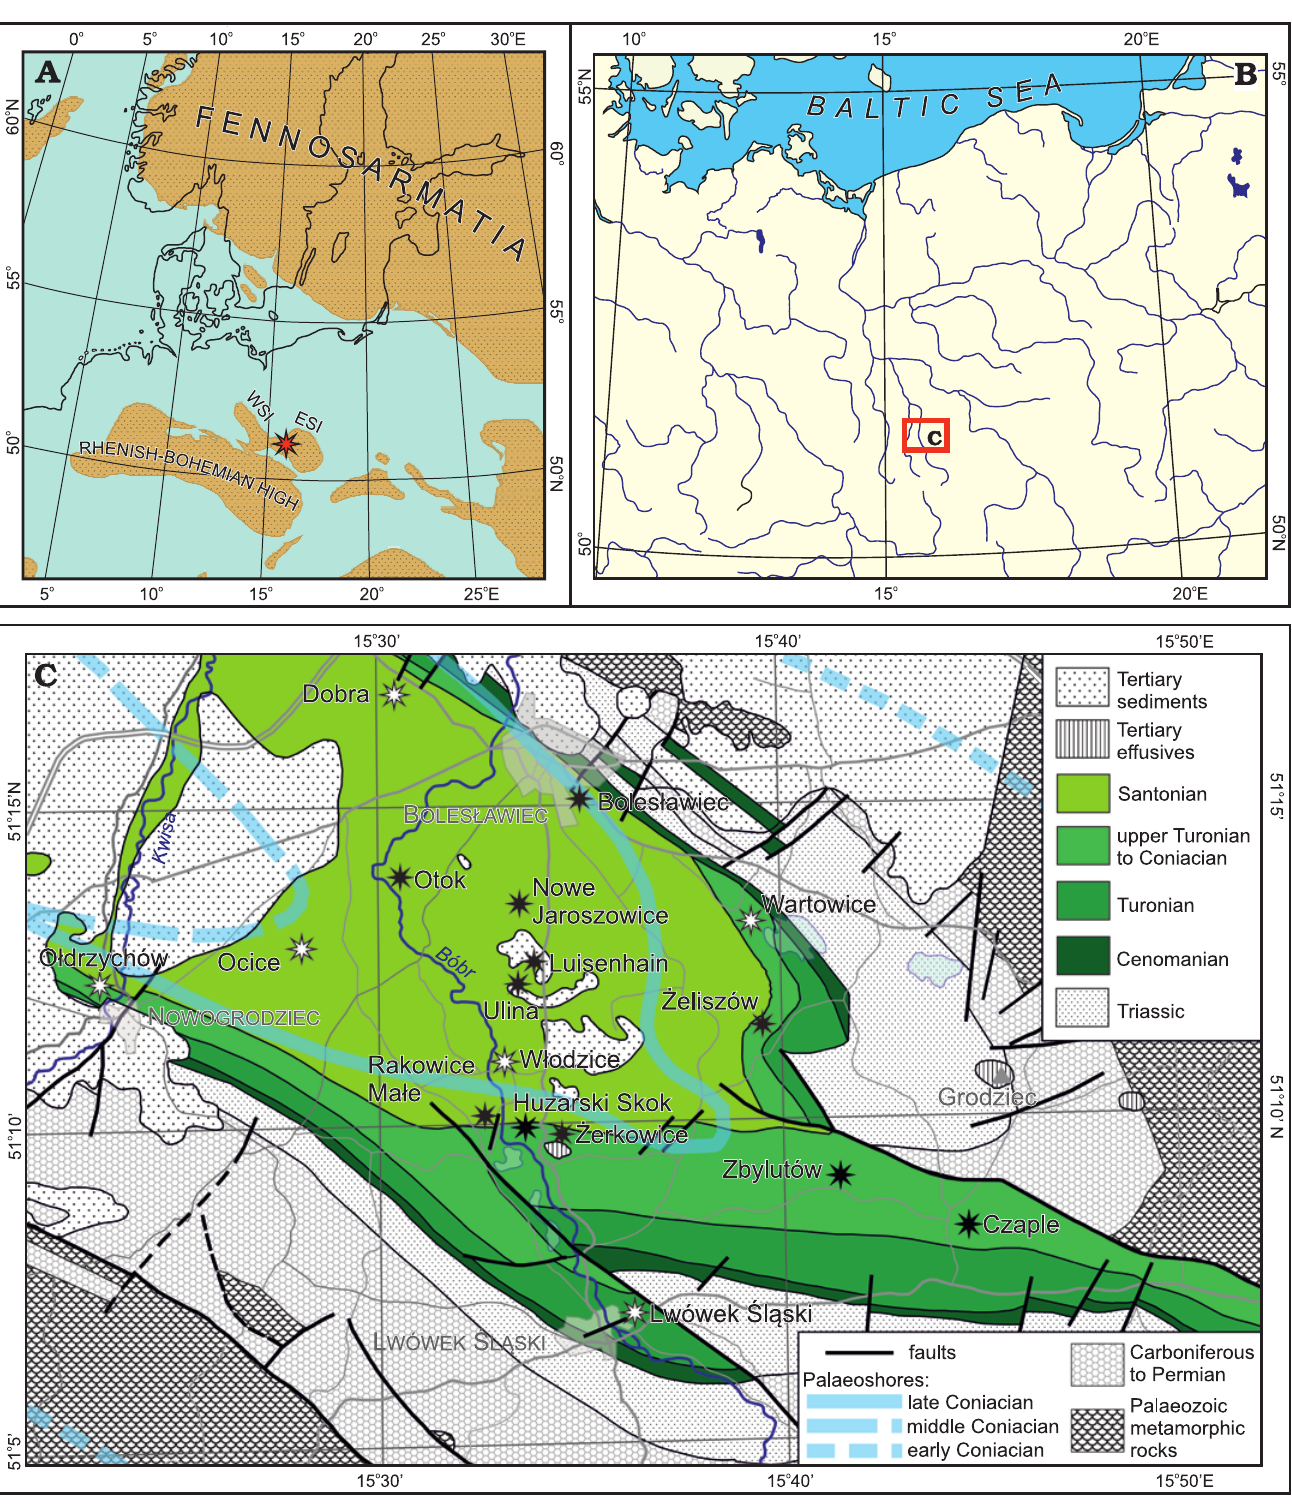
Fig. 1. Geographic, palaeogeographic, and geologic context of the studied flora. A . Late Cretaceous palaeogeography of Central and Northern Europe (after Ron Blakey from Csiki-Sava et al. 2015, modified after data in Chatziemmanouil 1982; Surlyk in Voigt et al. 2008; Halamski 2013; Halamski et al. 2016). The red asterisk shows the presumed position of the studied flora. ESI, East Sudetic Island; WSI, West Sudetic Island. B . Geographical location of the study area in Central Europe. C . Bedrock geological map of northern Silesia (pre-Cenozoic redrawn, simplified and partly corrected after Kozdrój et al. 2001; Cenozoic simplified after Sawicki 1966, 1995) with approximate locations of early, early middle, and late Coniacian palaeoshores (after Leszczyński 2018: fig. 40A, B, D). The studied localities (see Appendix 1) are shown by asterisks, black for those whose location is known in detail, white for those for which a precise location cannot be